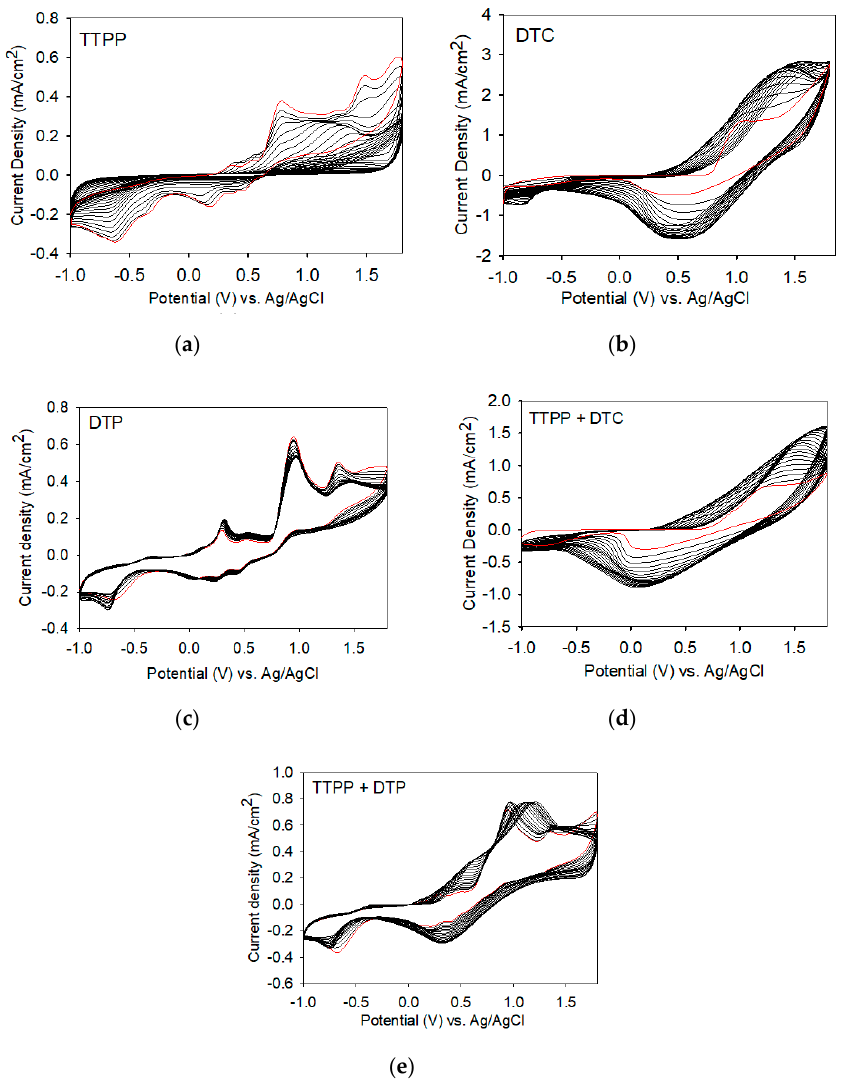
Figure 3. Cyclic curves of: ( a ) 2 mM TTPP; ( b ) 2 mM DTC; ( c ) 2 mM DTP; ( d ) 2 mM TTPP + 2 mM DTC; and ( e ) 2 mM TTPP + 2 mM DTP in 0.1 M lithium perchlorate / acetonitrile. The red line indicates the first